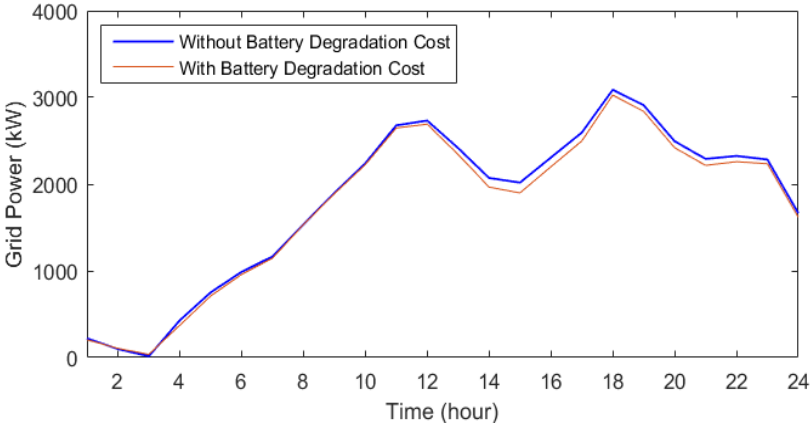
Figure 13. Power loss of the 33-bus distribution network without and with battery degradation cost using the IGJO.